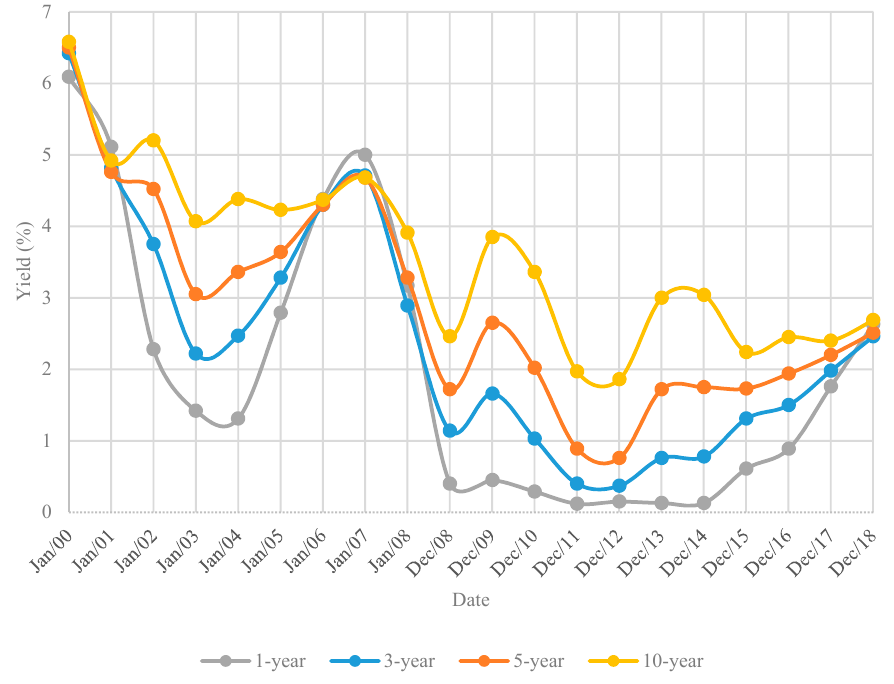
Figure 1. U.S. Treasuries Interest Rates.